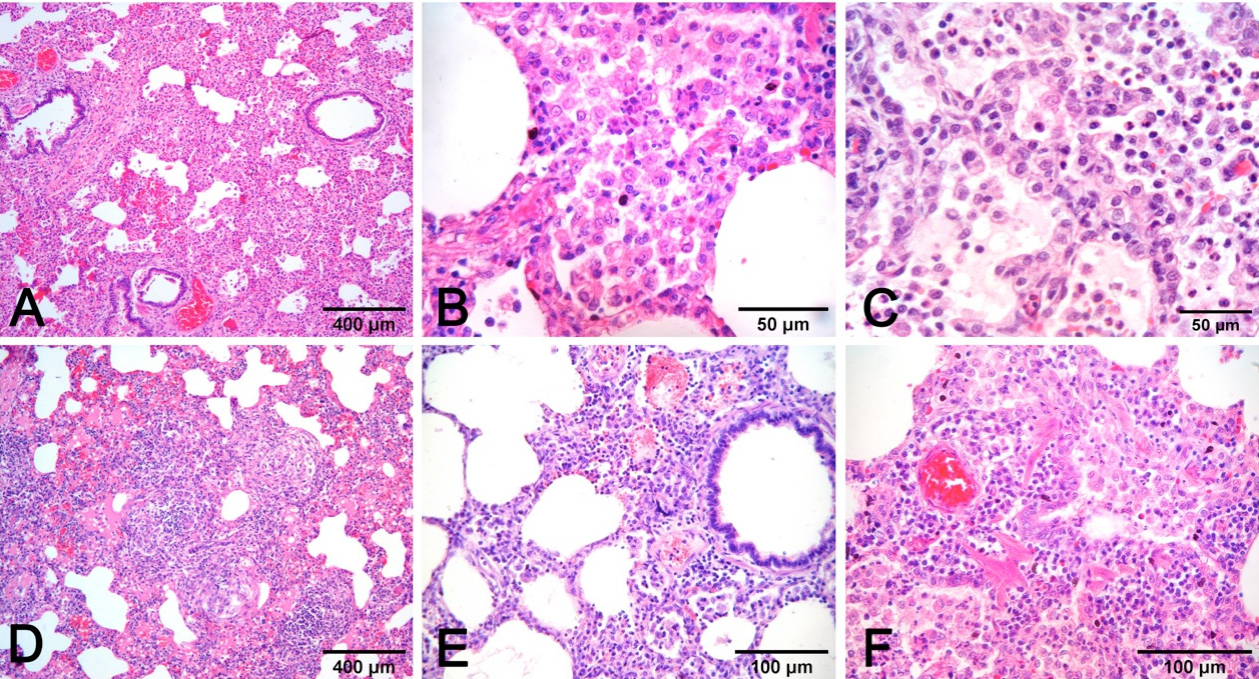
Figure 8. Interstitial pneumonia in PRRSV ( A – C ) and PCV2 ( D – F ) infections share similarities that need etiologic validation. A granulomatous pattern of inflammation ( D ) is suggestive of PCV2 pneumonia, whereas it is lacking in PRRSV pneumonia. This latter infection is characterized by macrophage alveolar exudation and necrosis ( B ) and type II pneumocyte hyperplasia ( C ) in alveolar walls. In PCV2 pneumonia, both alveolar septa and peribronchial space are thickened ( E ), and bronchiolar necrosis ( F ) can be recognized. H–E stain.